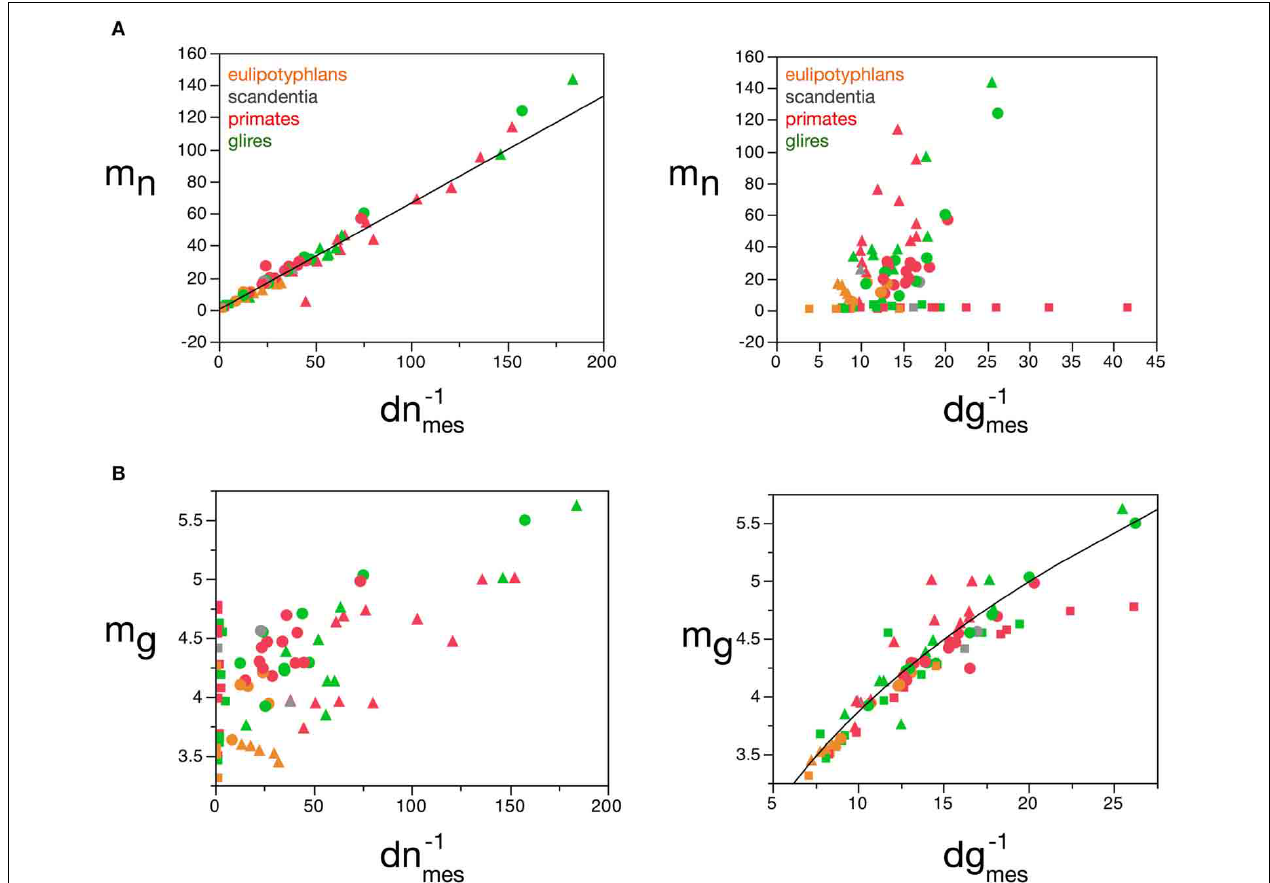
a function of the inverse of the measured glial density in the structure ( d − 1 gmes , right). Cell mass given in picograms, and the inverse of cell densities in picogram/neuron. Functions plotted are (A) m n = 0.649 ( d − 1 nmes ) 1 . 004 ± 0 . 019 ( r 2 = 0 . 973, p < 0 . 0001) and (B) m g = 1.648 ( d − 1 gmes ) 0 . 370 ± 0 . 017 ( r 2 = 0 . 897, p < 0 . 0001). Cerebral cortex plotted as circles, cerebellum as squares, and rest of brain as triangles; eulipotyphlans shown in orange, primates in red, and rodents in green. Data from Herculano-Houzel et al. (2006, 2007, 2011), Azevedo et al. (2009), Sarko et al. (2009). and Gabi et al.